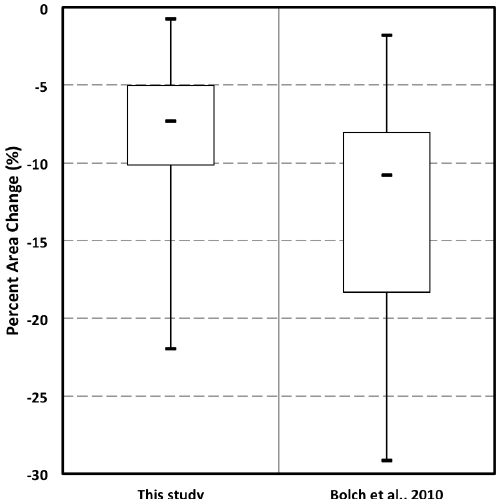
Figure 8. Box-and-whisker plots showing the maximum, interquar- tile range, median, and minimum percent area change for 28 glaciers from 1985 to 2005 for this study and that of Bolch et al.